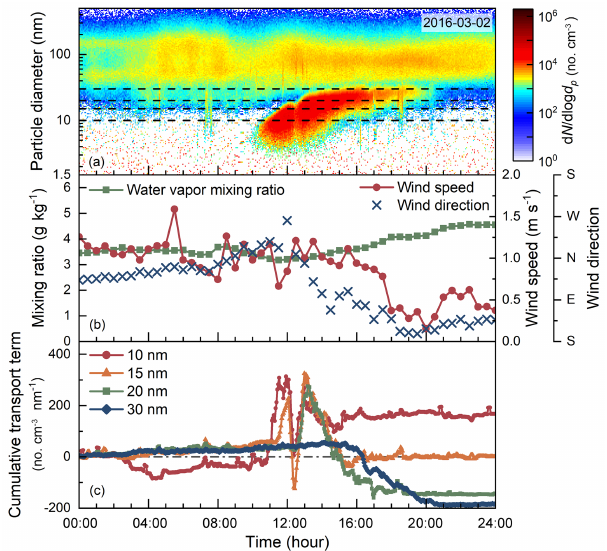
Figure 9. The contour plot of aerosol size distribution and the time series of d N / d d p , the cumulative transport term, the cumulative CoagSnk, and the cumulative growth term on 23 March 2016, in ur- ban Beijing; d N / d d p and the cumulative transport term were aver- aged every 15min. The contribution of coagulation to the estimated grow rate was corrected (Stolzenburg et al., 2005). The cumulative CoagSrc was estimated but not shown considering its negligible val-